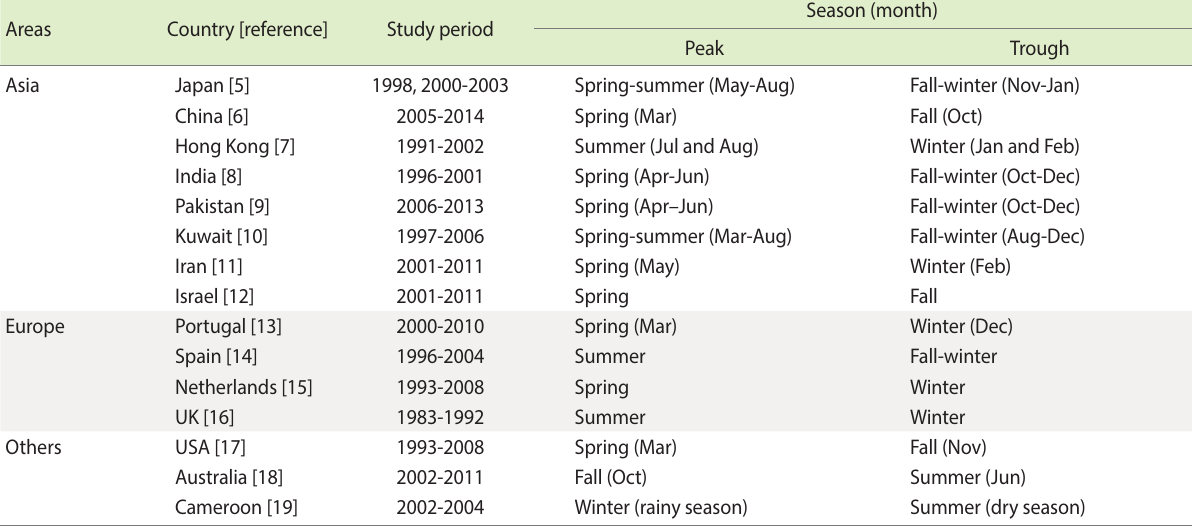
Table 1. Summaries of the seasonality of tuberculosis by countries